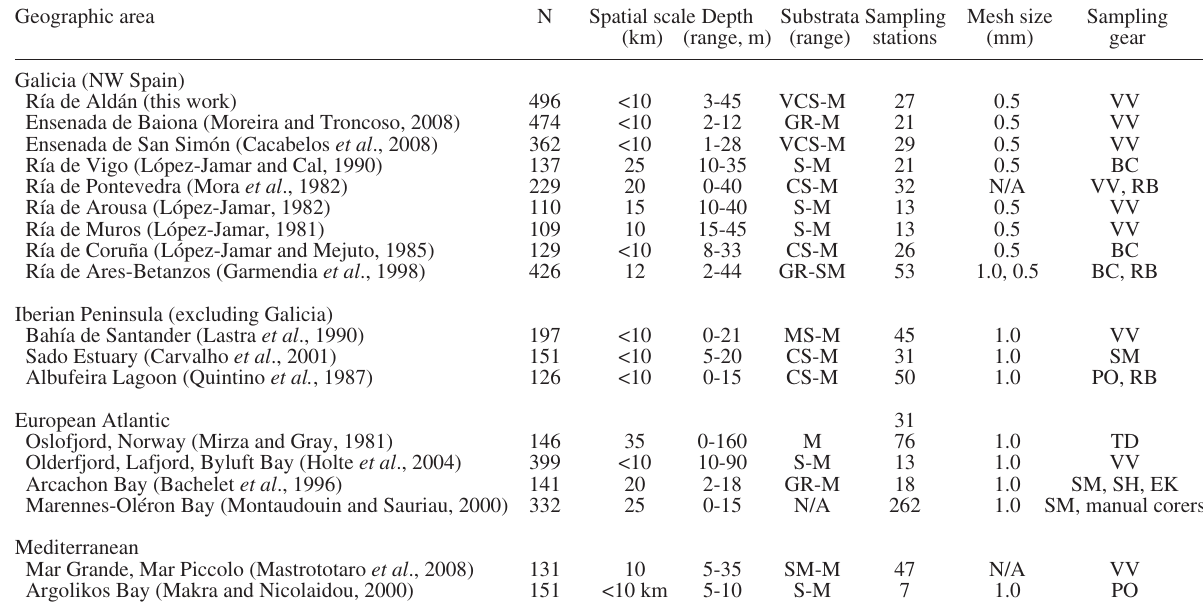
Table 6. – Comparison of total number of species (N) of macrobenthic fauna in the Ría de Aldán and that in other European areas. Main physical features of sampling areas and sampling methodology are also indicated for bibliographic references. Geographic